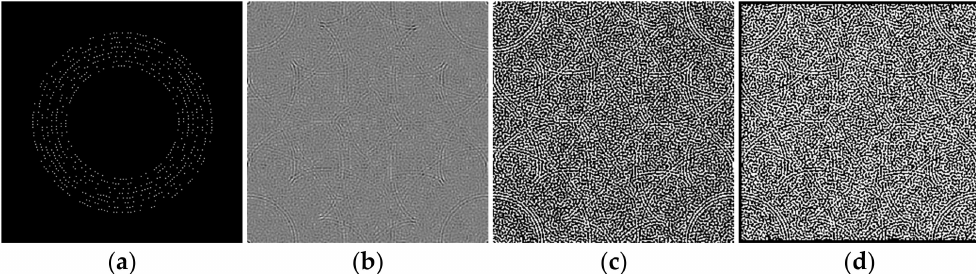
Figure 4. Generation process of W B . ( a ) Arrange message sequence in circle regions of a zero matrix; ( b ) inverse Discrete Fourier transform (IDFT) of matrix ( a ); ( c ) binarization of matrix ( b ); ( d ) add a frame for matrix ( c ).